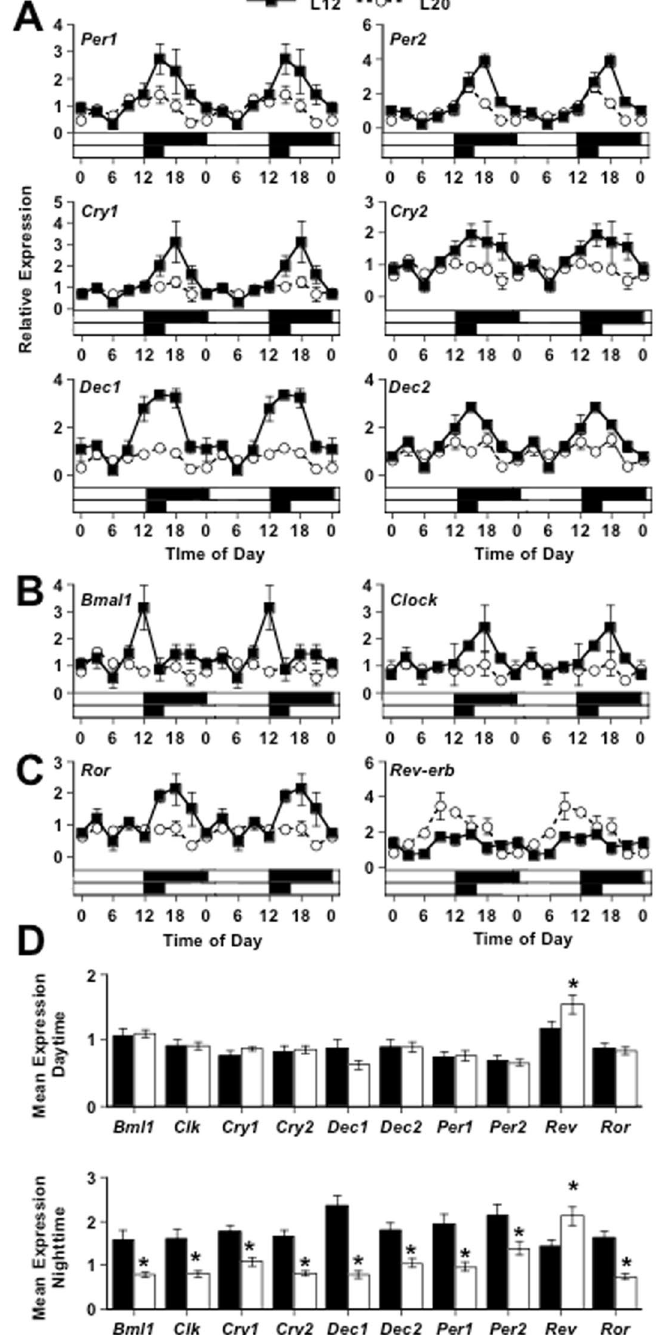
Figure 3. Long days alter clock function in the dorsal hippocampus. L20 attenuated rhythms in most core clock genes ( A,B ) and ancillary clock genes ( C ), with the exception of Rev-erb . Note that daily changes in gene expression are double-plotted to facilitate rhythm analysis. ( D ) L20 altered clock gene expression in a phase- and transcript specific manner. * Student’s t-test, p < 0.05. For most clock genes, nighttime expression was decreased, with the exception that Rev-erb expression was increased. Statistical evaluation of transcript rhythms and group differences are described in Table